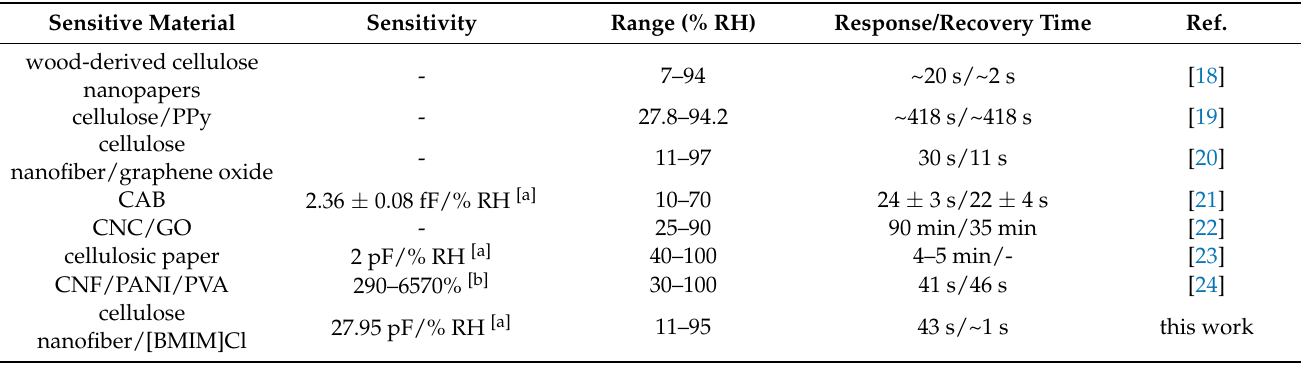
Figure 4. Response and recovery curves of CIL@Cl-1–4 sensors: ( a ) five circles between 11% RH and 95% RH, and ( b ) is the enlarged shaded part of ( a ). Table 1. Comparison of the sensing performance of the prepared sensor in this work with the reported cellulose-based humidity sensors.